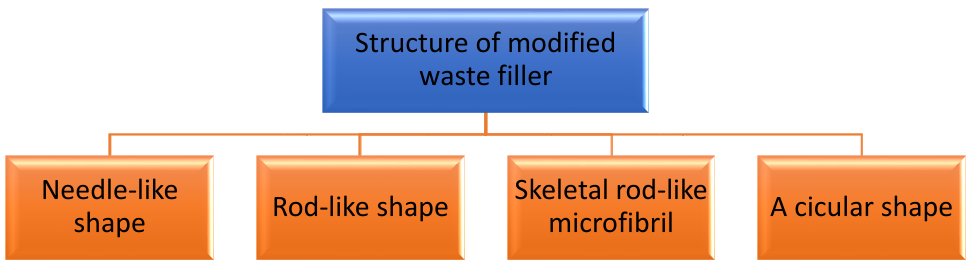
Figure 1. The different structure of modified waste/raw natural filler.